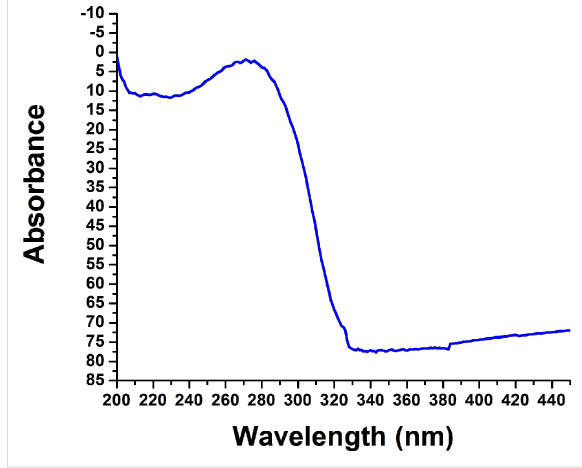
Figure 7: Solid state diffuse reflectance UV–vis spectra of Ta 2 O 5 nanoparticles.